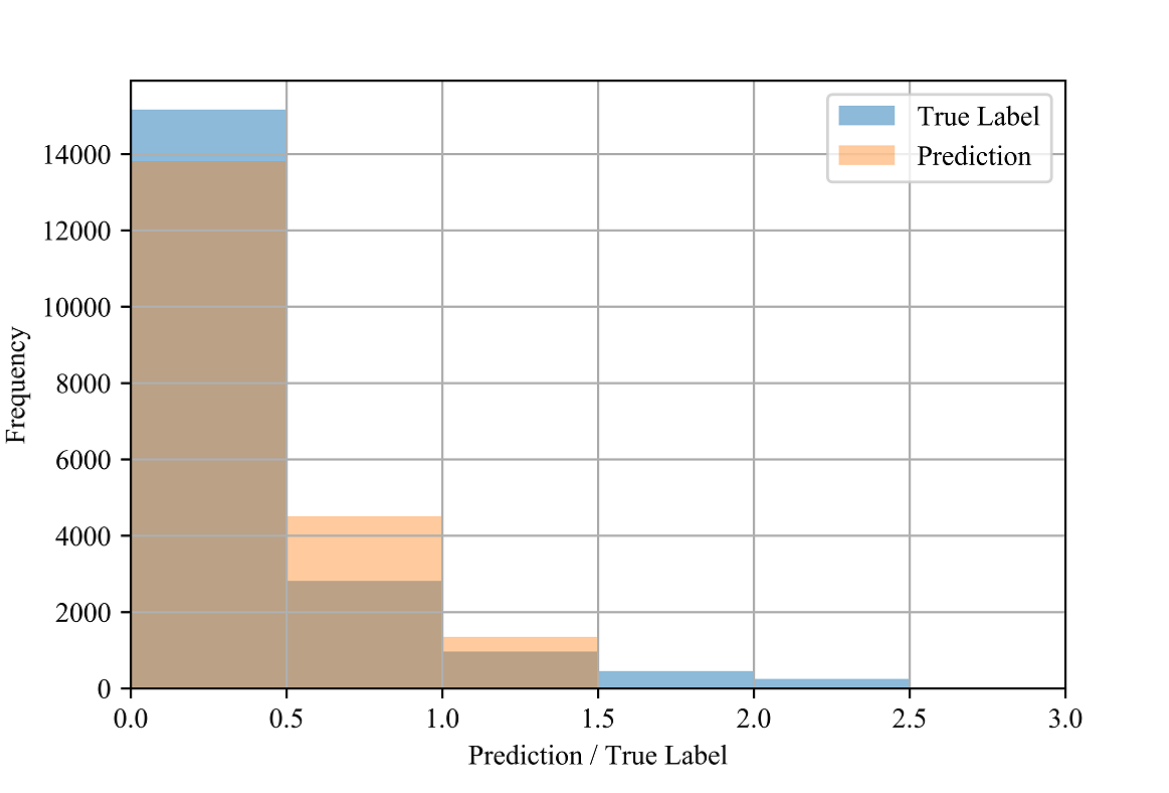
Figure 7. Distributions of the test labels (ie, true confirmed infection growth) and model predictions (n=19,669) for the cross-validation method.